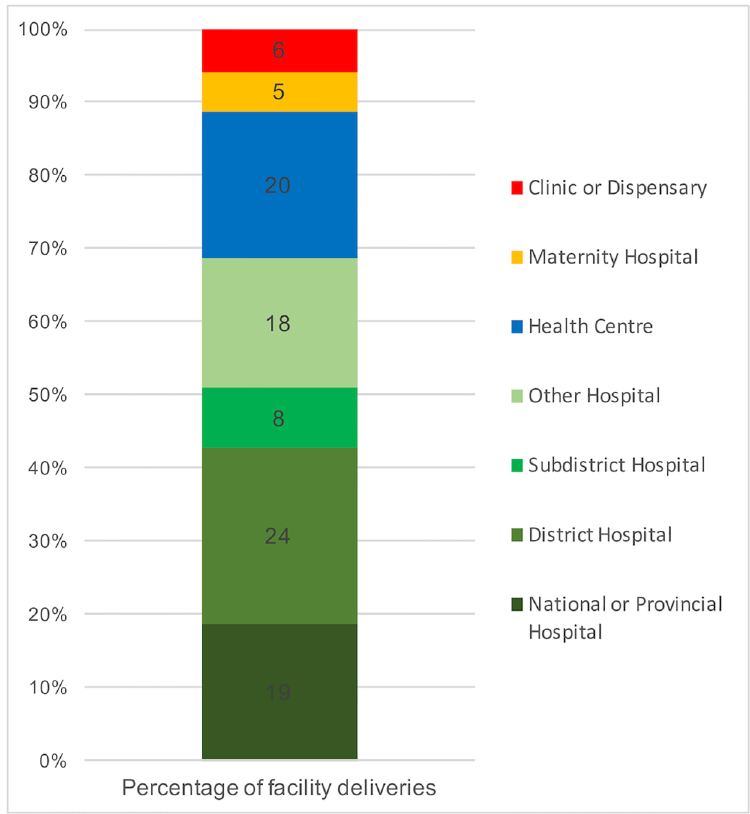
Fig 5. Where are the facility births occurring? Percentage of facility deliveriesoccurring in each level of facility.